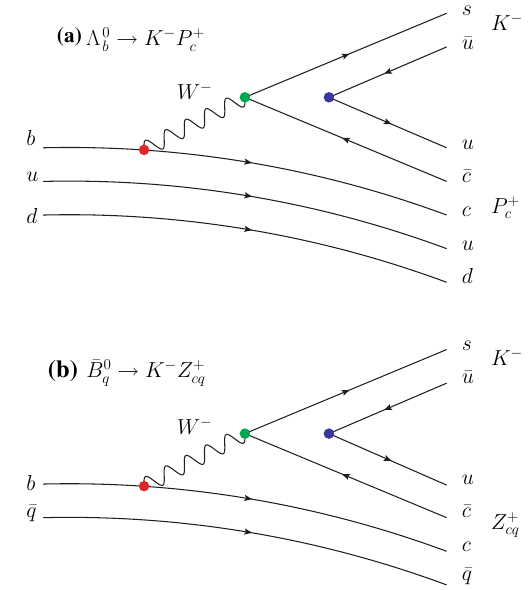
Fig. 2 Exotic states production by external W -emission in (a) the − decay,and(b)the ¯ B 0 → Z + − π + and ¯ B 0 − . (cid:5) → P + → Z ( ∗ ) b cs K c K c K s The diagram for the charge conjugate channel of B + → Z + cs φ can be obtained with u ¯ u → s ¯ s in (b) decay by the internal W -emission in Fig. 1(a) are too ener- getic to form a bound pentaquark. The dominant pentaquark production process is anticipated to be the external W - emission amplitudes in Fig. 2(a) [63]. The close analogous diagrams for bottom meson decays are shown in Fig. 1(b) and ¯ ¯ → J /ψ K − K + B 0 B 0 → J /ψ K − π + and Fig. 2(b) for s